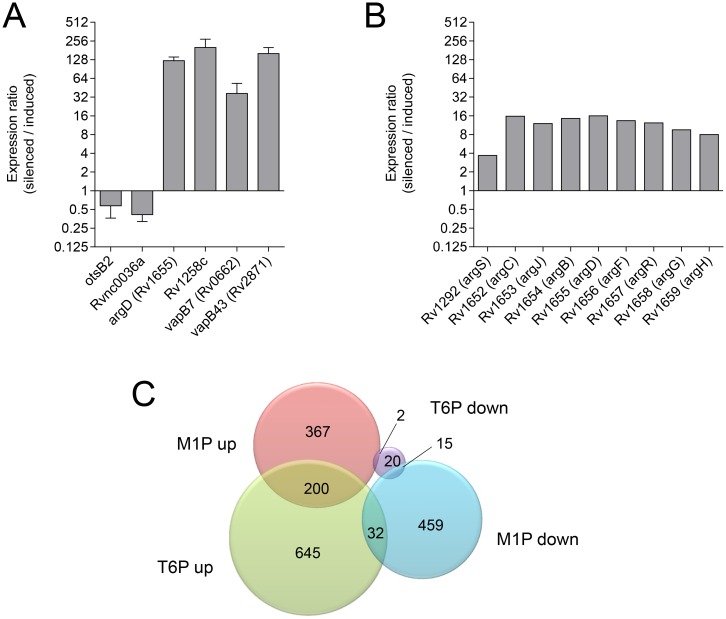
Genome-wide characterization of the T6P-elicited stress response profile.(A) Quantitative real time PCR analyses of selected transcripts to corroborate RNAseq results. qRT-PCR data were normalized to 16S rRNA, and the expression ratios of partially silenced cells of the M. tuberculosis c-otsB2-tet-on mutant compared to fully induced cells are reported as means of triplicates ± SEM. (B) Upregulation of arginine biosynthesis genes in T6P stressed cells of the partially silenced c-otsB2-tet-on mutant according to RNAseq data. (C) Diagram showing the overlap of the T6P stress response with the M1P stress response. Microarray data for M1P stress have been reported previously [13] and were obtained through NCBI Gene Expression Omnibus (GEO data set GSE18575). Only genes with a differential regulation of ≥ 2 are included.